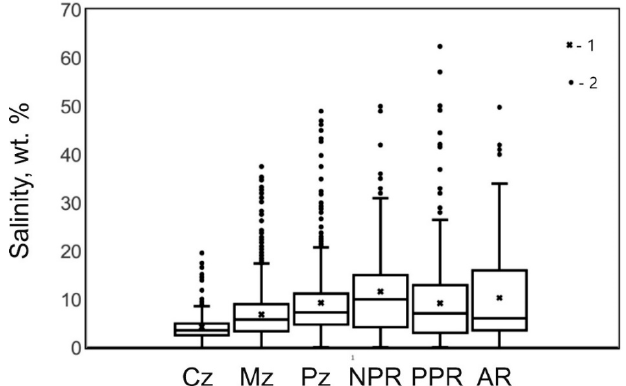
Figure 7. Boxplot diagrams for the salinity of the mineralizing fluids of orogenic gold deposits of various age.